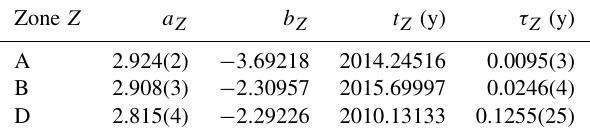
Table 4. Best fit parameters for Shannon entropy of zones A, B and D after the main earthquake using the exponential trial function of Eq. (6).